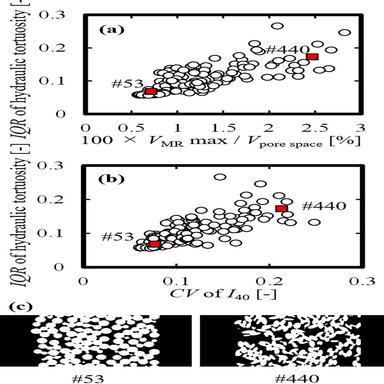
(a) Relationship between the IQR of the hydraulic tortuosity and normalized VMR max. VMR max is normalized by the total volume of the pore space. (b) Relationship between IQR and CV of I40. Sample #53 (small VMR max) and #440 (large VMR max) are shown as examples. (c) Cross-sectional images of the two samples.